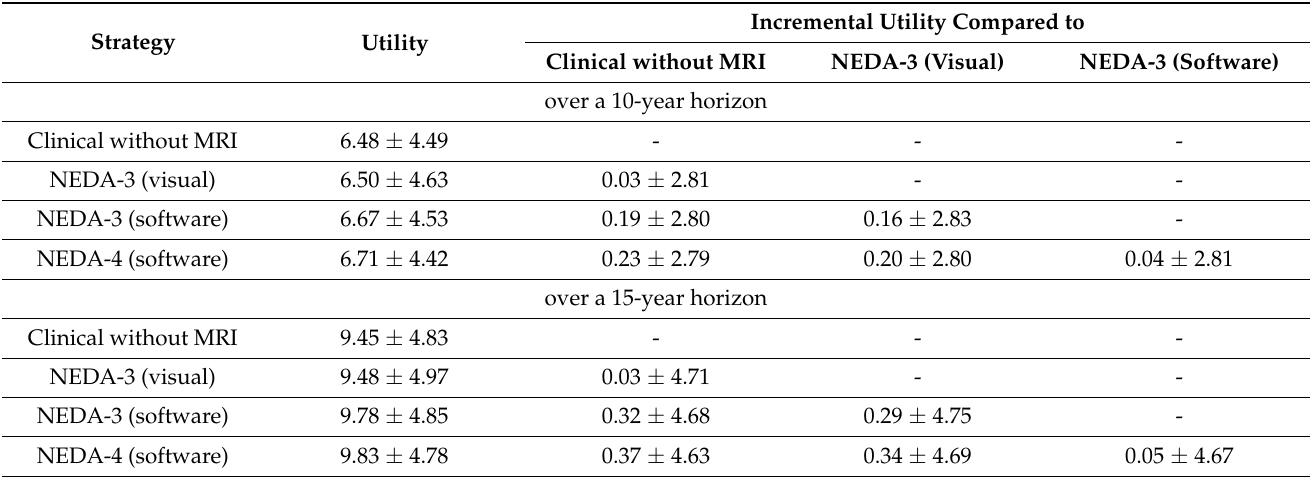
Incremental Utility Compared